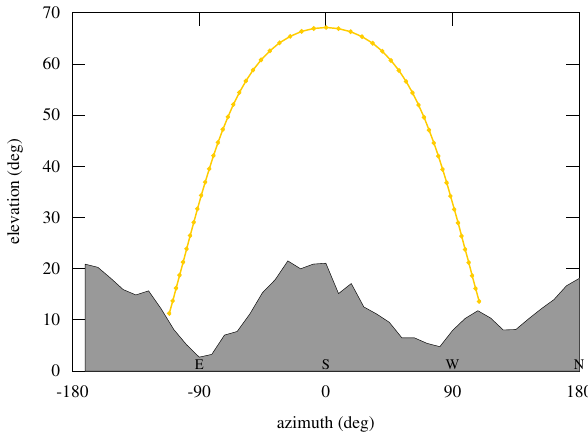
Fig. 2. Horizon and sun elevation at Saint-Christophe. The sun trajectory for 8 June is drawn from 05:00UT to 17:45UT. Circles are plotted every